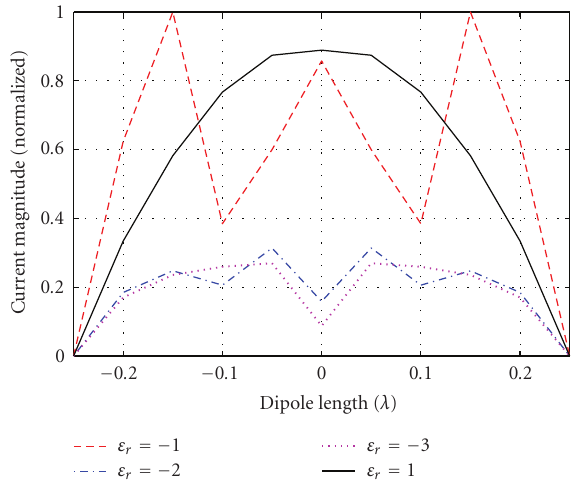
Figure 4: Current distribution at 750 MHz. Other parameters: L = 200 mm, r = 0 . 3175 mm, a = 0 . 3175 mm, b = 1 . 8542 mm, ε r = 1, and N = 10.